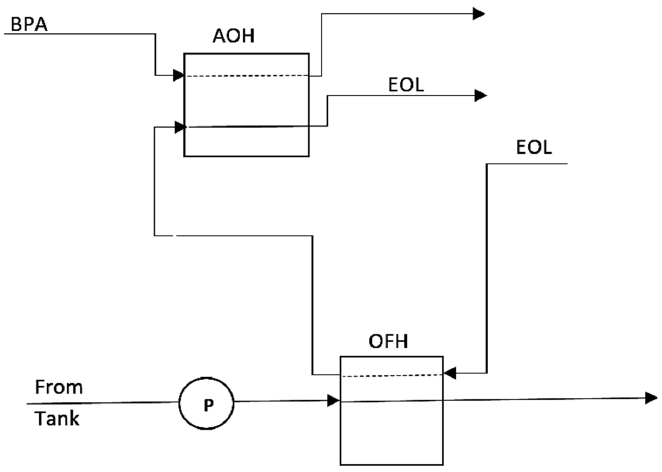
Figure 4. Thermal management system embodiments with two heat exchangers and using bypass air (EOL: Engine Oil Line, BPA: Bypass Air).